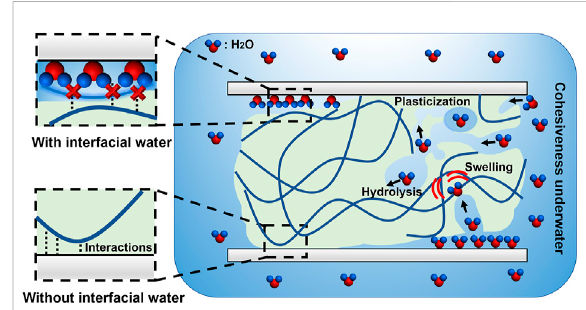
FIGURE 1 Obstaclesanddif fi cultiesinunderwaterbonding.Underwater bonding faces with the obstacles of interfacial water and the dif fi cultiesinachievinghighcohesivenessunderwater.Withoutthe interfacial water, the adhesive molecules are able to bond with the target surfaces by multiple predetermined interactions. However, the interfacial water hinders the intimate contact between the adhesive molecules and surfaces, causing the failure of the underwater bonding. In addition, achieving high cohesiveness underwater is also challenging. The adhesives face the dif fi culties in curing underwater and the risk of hydrolysis, swelling, plasticization in water, which may weaken the structure of the